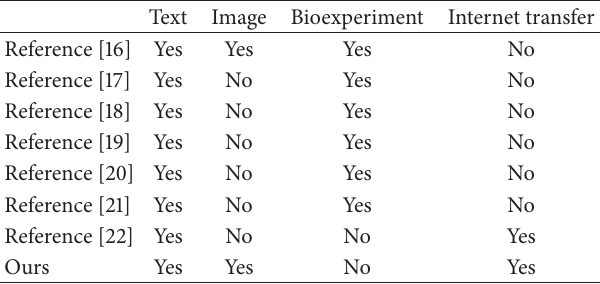
Table 8: Comparison with the biotic experimental algorithms. Text Image Bioexperiment Internet